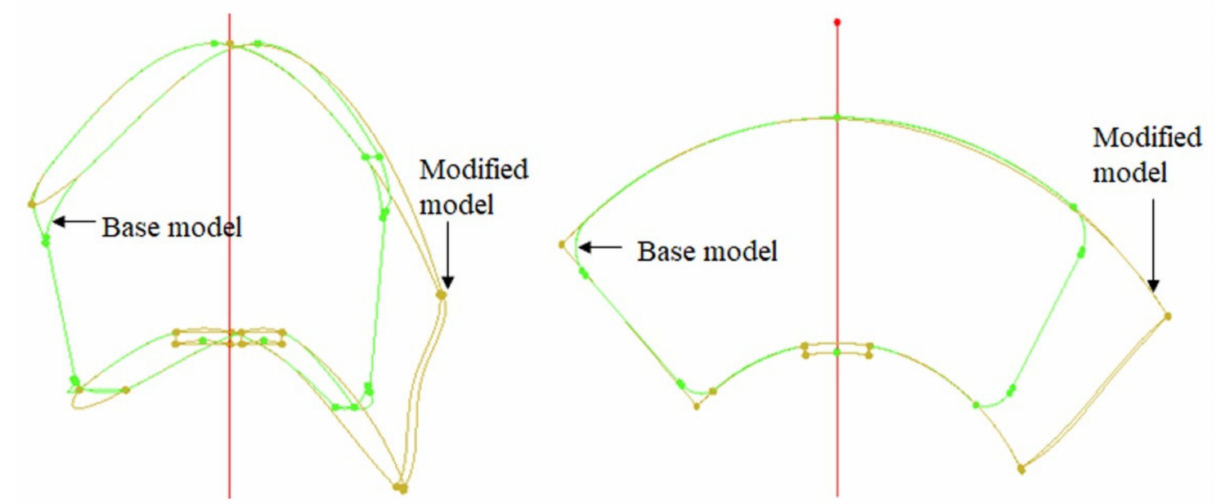
Figure 25. Changing the shape of the runner vane.